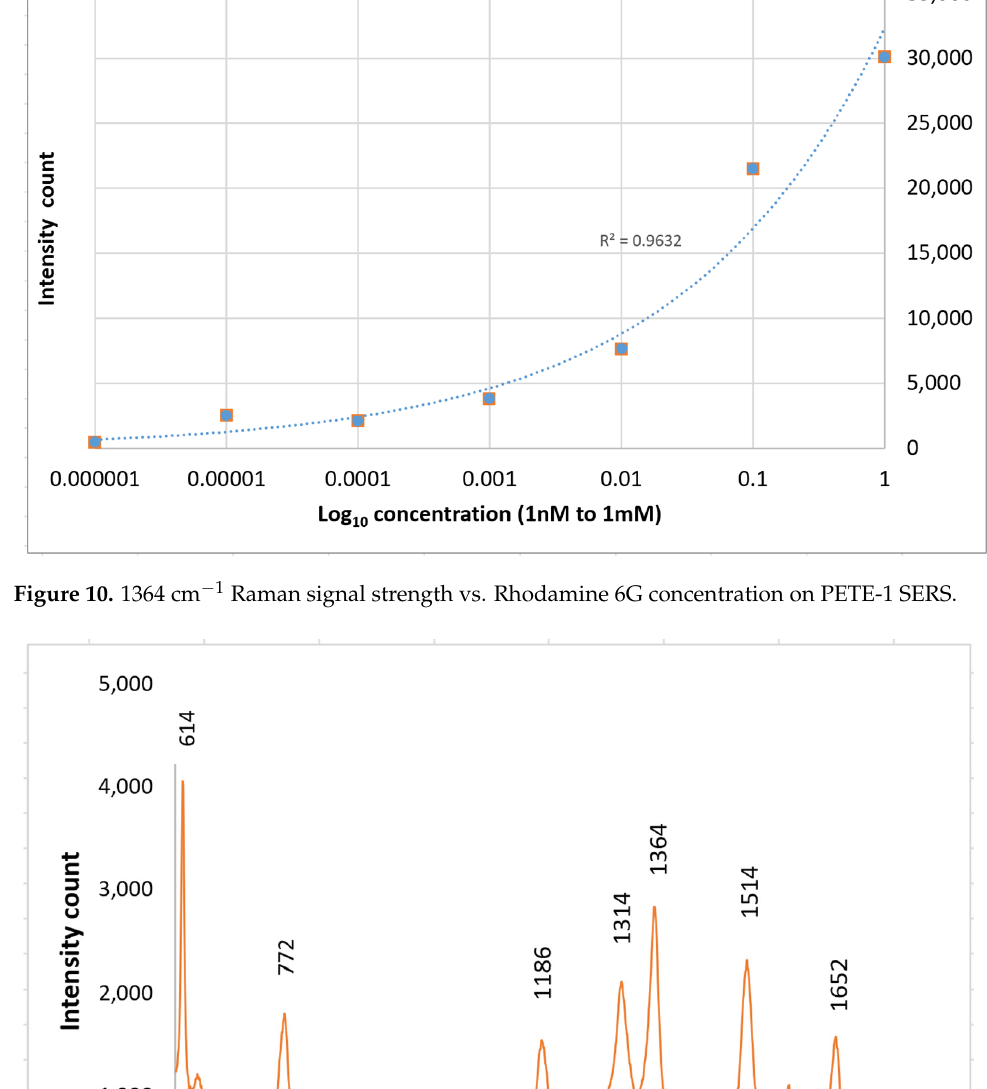
Figure 12. Top traces, Raman spectrum of 1 nm to 1 mm concentrations of R6G obtained after trans- ferring silver nano-sphere suspension to epoxy on glass. Bottom trace, no R6G. For clarity, the spec- tra have been offset vertically.